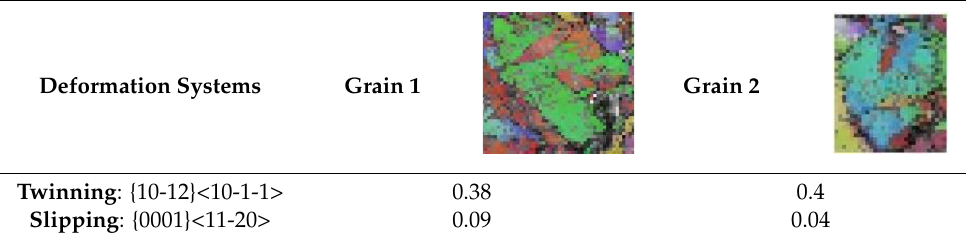
Figure 5. OIM for {10-12}<10-1-1> twinning in one globular α grain. ( a ) OIM in the rectangle region of Figure 4e. ( b ) Orientation of unit cell for matrix (green region in ( a )). ( c ) Orientation of unit cell for twinning (red region in ( a )), the “X” stands for the normal direction of the plate. Table 2. Schmidt factor of twinning and slipping for the grains containing {10-12} <10-1-1> twinning.